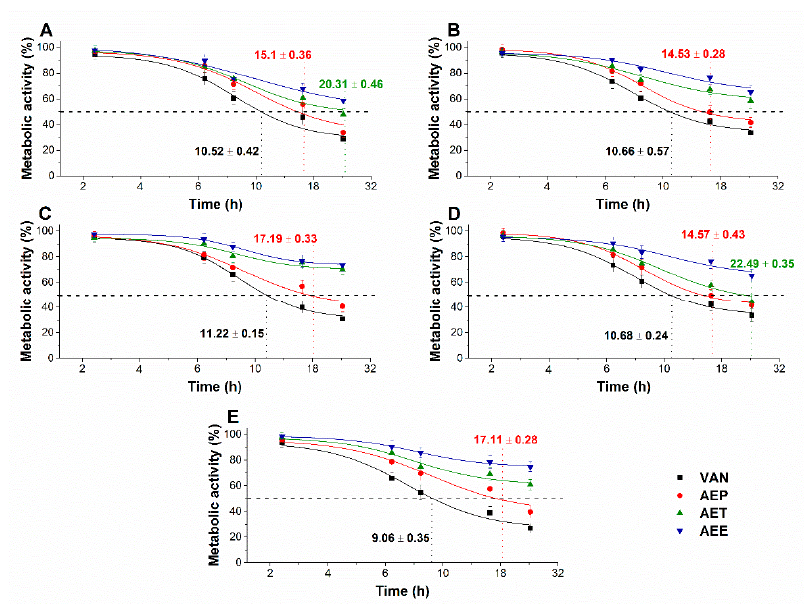
Figure 15. Effects of AEP, AET and AEE at their MEC 10 concentrations on the metabolic activities of the planktonic E. coli ( A ), S. aureus ( B ), B. subtilis ( C ), P. aeruginosa ( D ), and S. pyogenes ( E ) compared to their respective 0 h samples and vancomycin (VAN) standard antimicrobial controls after 2, 6, 8, 16 and 24 h of treatment (mean ± SD, n = 6 independent experiments each with three technical replicates).